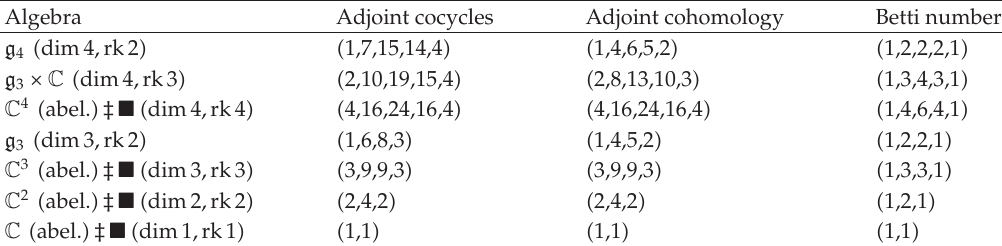
Table 13: Cohomology table for NLAs of dimension (cid:2) 4 . Algebra Adjoint cocycles Adjoint cohomology Betti